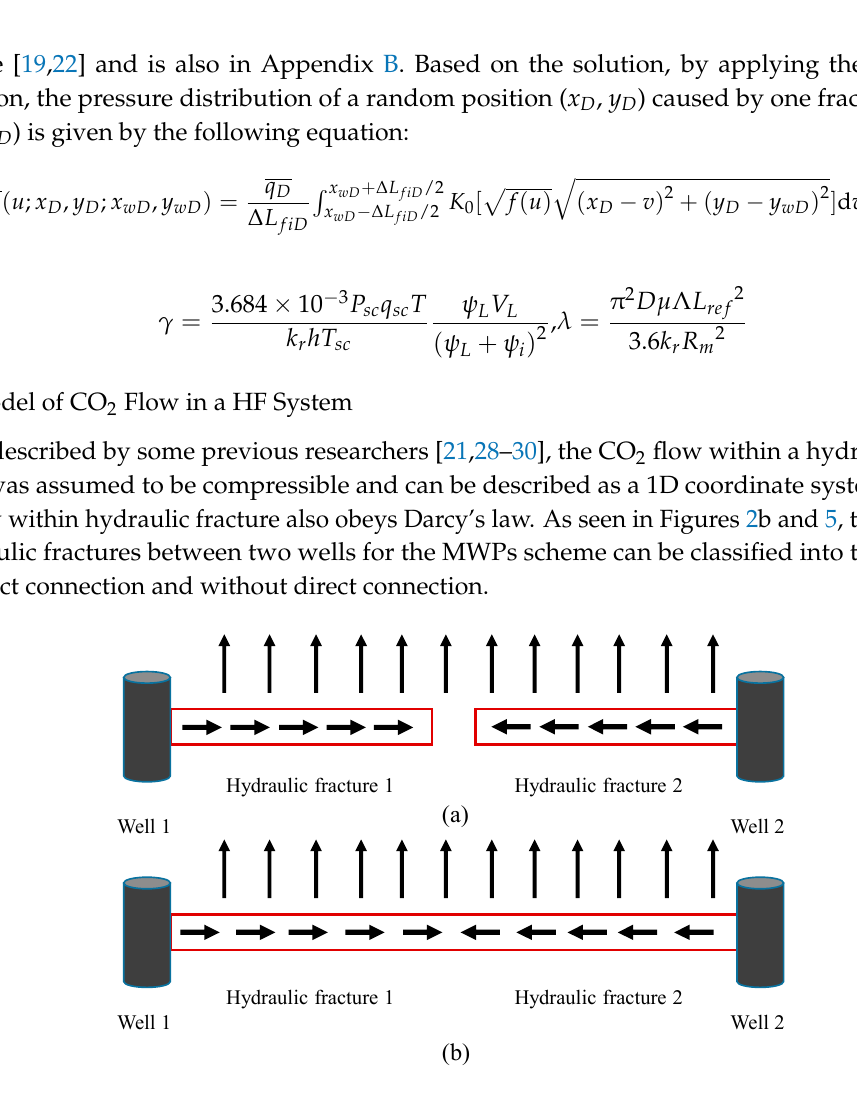
Figure 5. Plan view of CO 2 flow within HF system: ( a ) HFs are not connected between two wells; ( b ) HFs are connected between two wells.